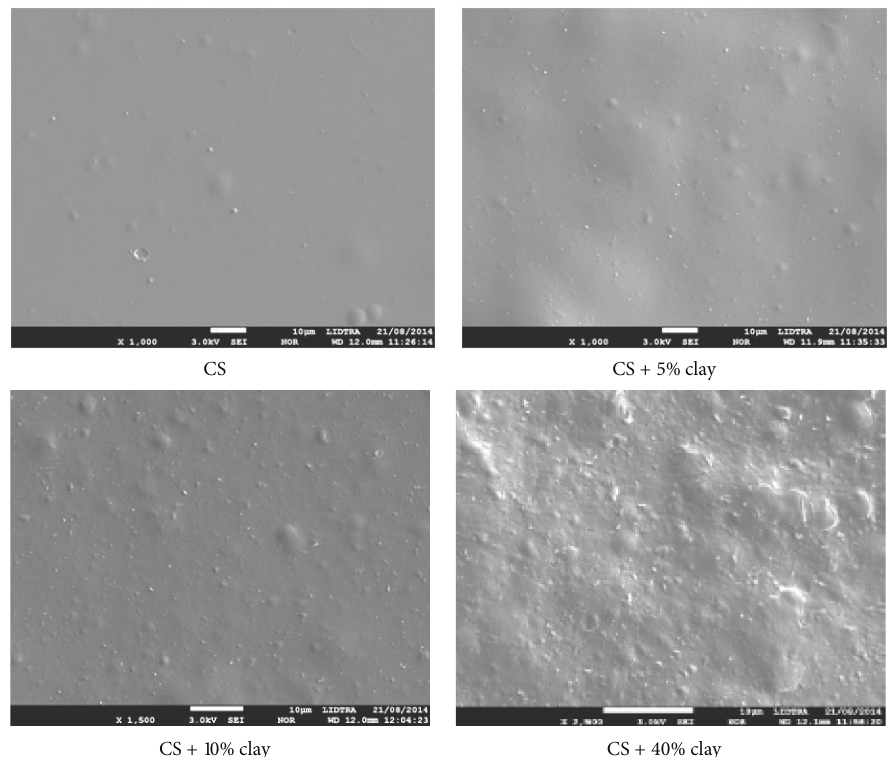
Figure 1: SEM images of CS-MMT composites prepared with different clay wt%.